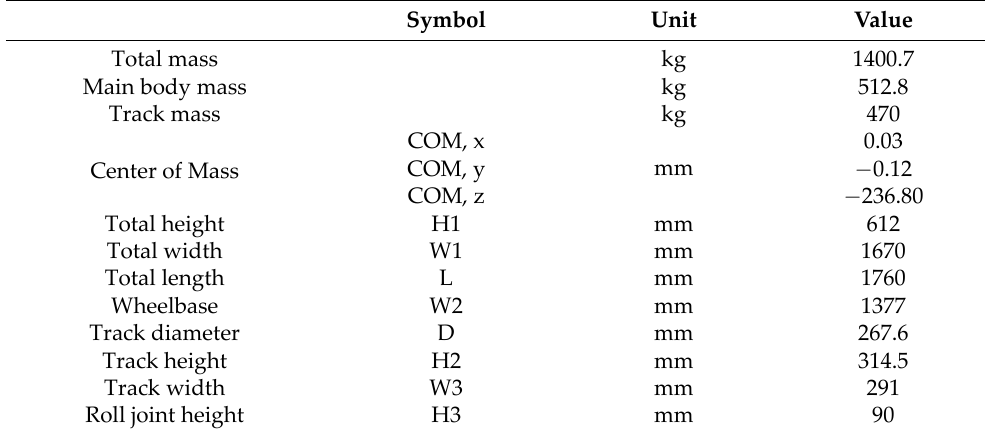
Figure 7. Overall simulation framework to verify the performance of the (1) TTCA-based driving velocity projection method and (2) velocity propagation driving velocity projection method based on the RecurDyn-Simulink co-simulator. Table 2. Mechanical dimensions of 3D model of PASTRo for proposed simulation.